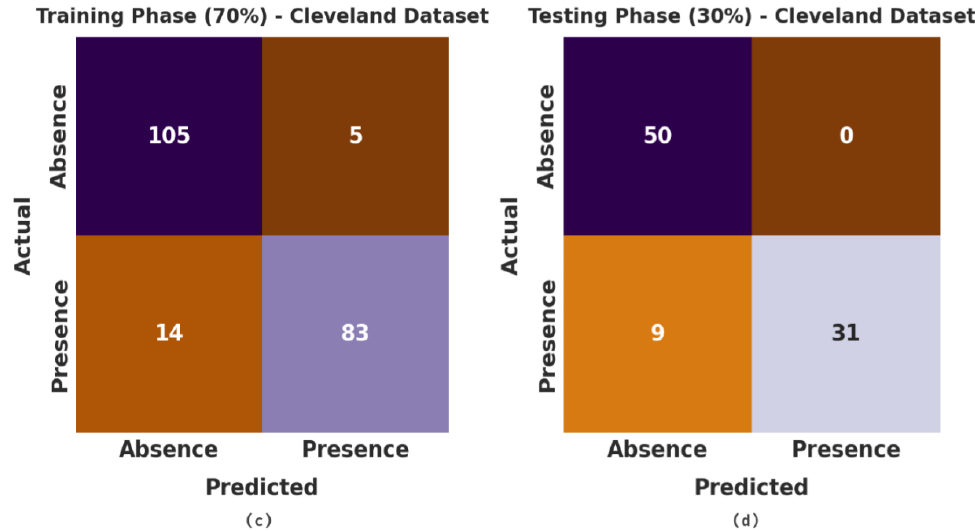
Figure 4. Confusion matrices of MLMDMC-ED method on Cleveland dataset ( a , b ) TR and TS database of 80:20 and ( c , d ) TR and TS database of 70:30.